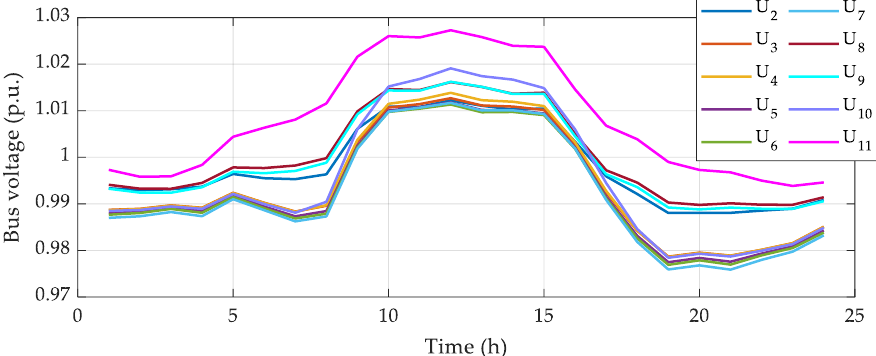
Figure 11. Microgrid hourly bus voltage profile for the selected day, under the OARPC.